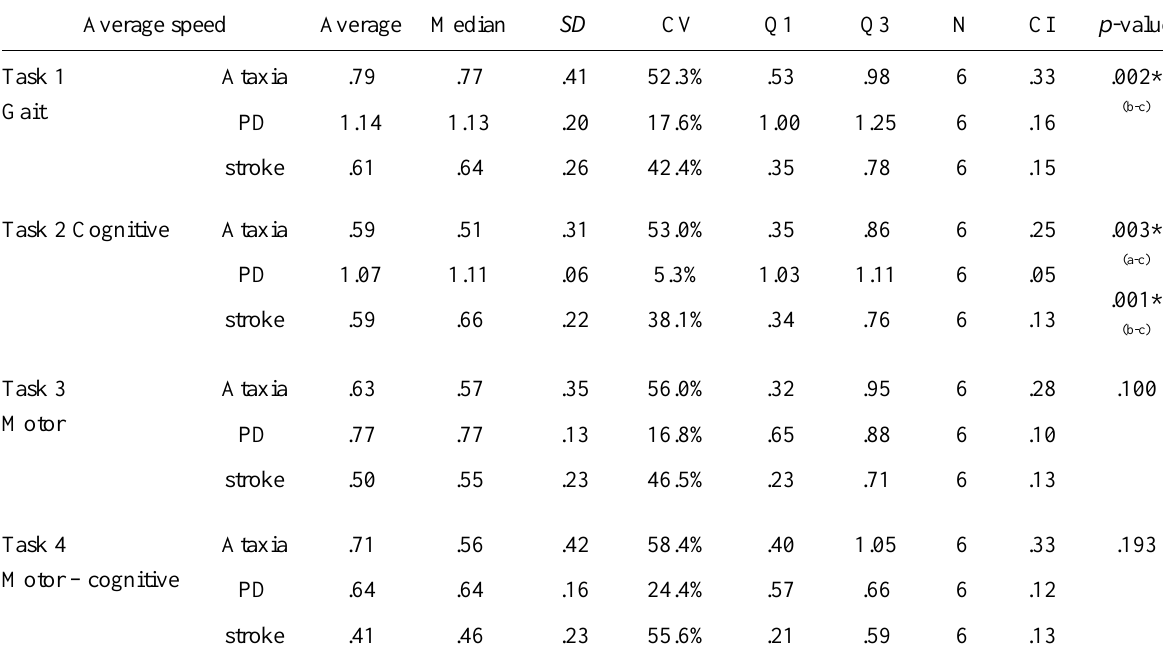
Performance on Gait Related to Average Speed in the Four Tasks Tested on the Ataxia, PD and Stroke Groups